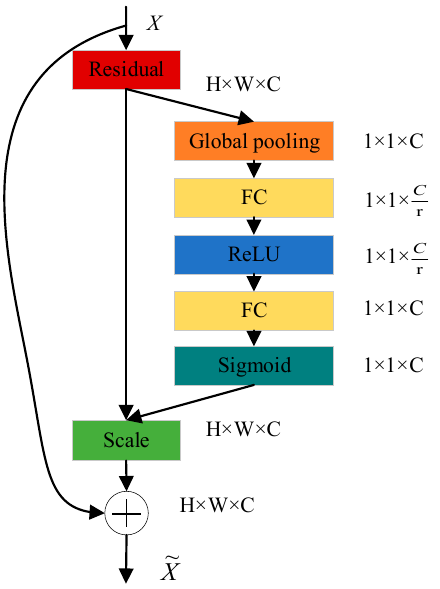
Figure 3. Structure of SENet.